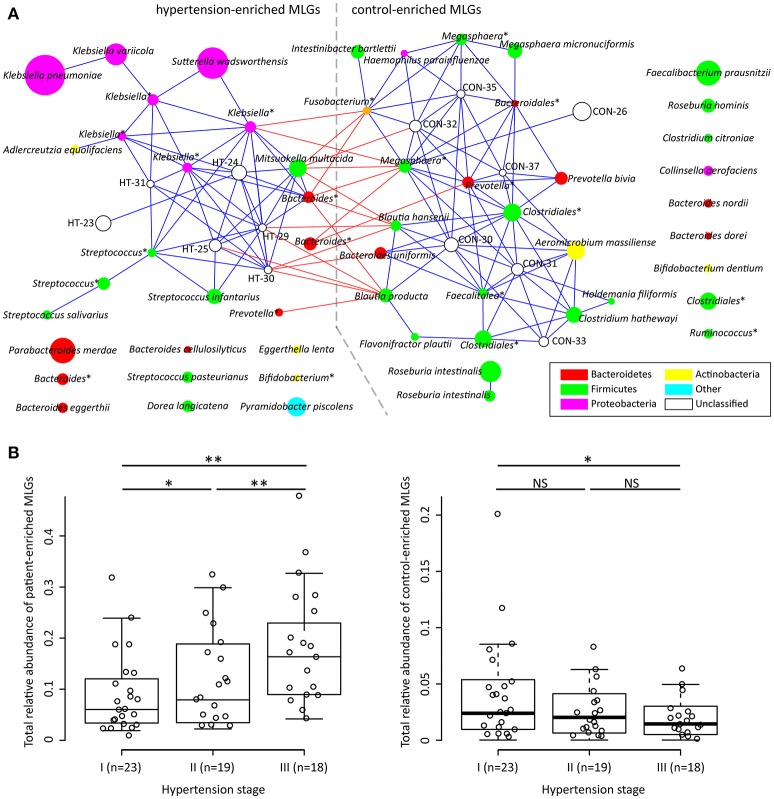
Characterization and interconnection of hypertension-associated MLGs. (A) Co-occurrence network shows the interconnection of the hypertension- and control-enriched MLGs. Nodes depict MLGs with their ID or taxonomic assignment (unclassified MLGs under genus or higher taxonomy rank are marked by “*”) displayed in the center. The size of the nodes indicates the number of gene within the MLG. Connecting lines represent Spearman correlation coefficient ρ > 0.40 (represented by blue line) or < −0.40 (represented by red line). (B), Correlation of gross abundance of hypertension- and control-enriched MLGs with hypertension stage. NS, not significant; *, q < 0.05; **, q < 0.01; Mann-Whitney U-test corrected by FDR.